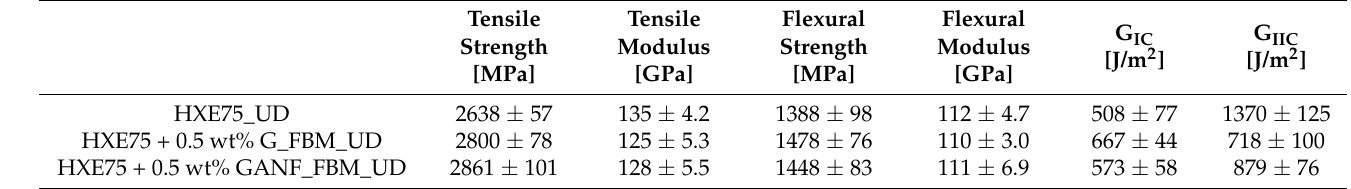
Figure 12. Mode I and Mode II fracture toughness test results of the composites under examination. Table 7. Mechanical characterization of the composites loaded with GNPs and